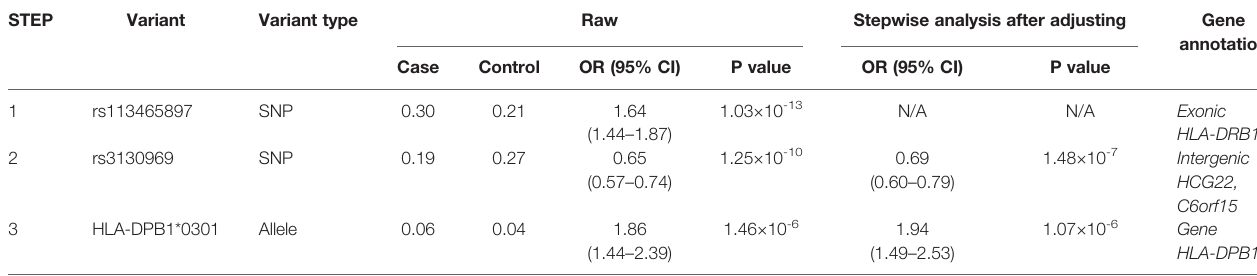
TABLE 1 | Results of stepwise conditional regression analysis of